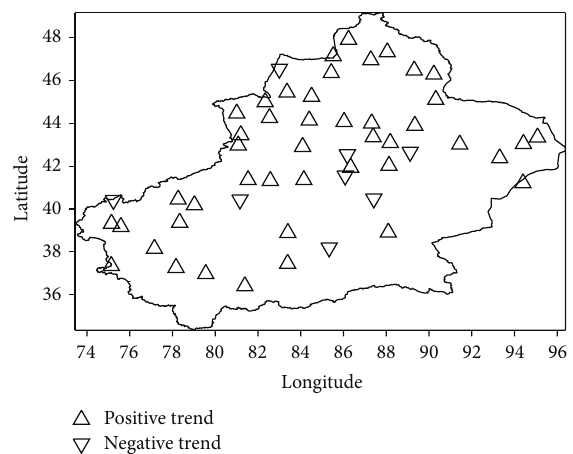
Figure 2: Change in intensities of annual maximum rainfall events